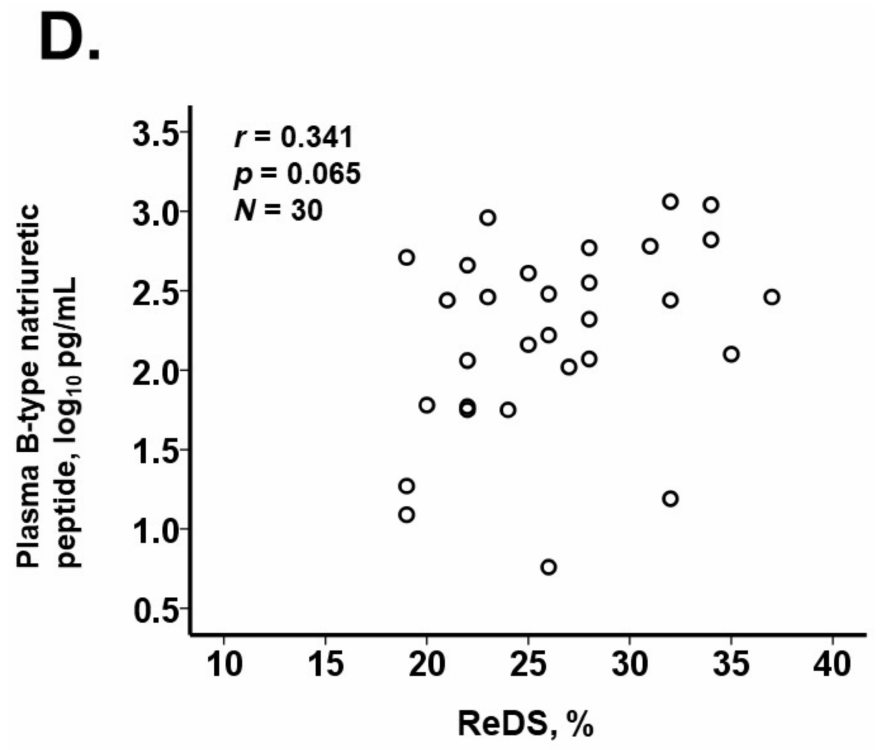
Figure 5. Correlation between ReDS values and other clinical variables including mean right atrial pressure ( A ), mean pulmonary artery pressure ( B ), E/e’ ratio ( C ), and plasma B-type natriuretic peptide ( D ). * p < 0.05 by Pearson’s correlation coefficient.